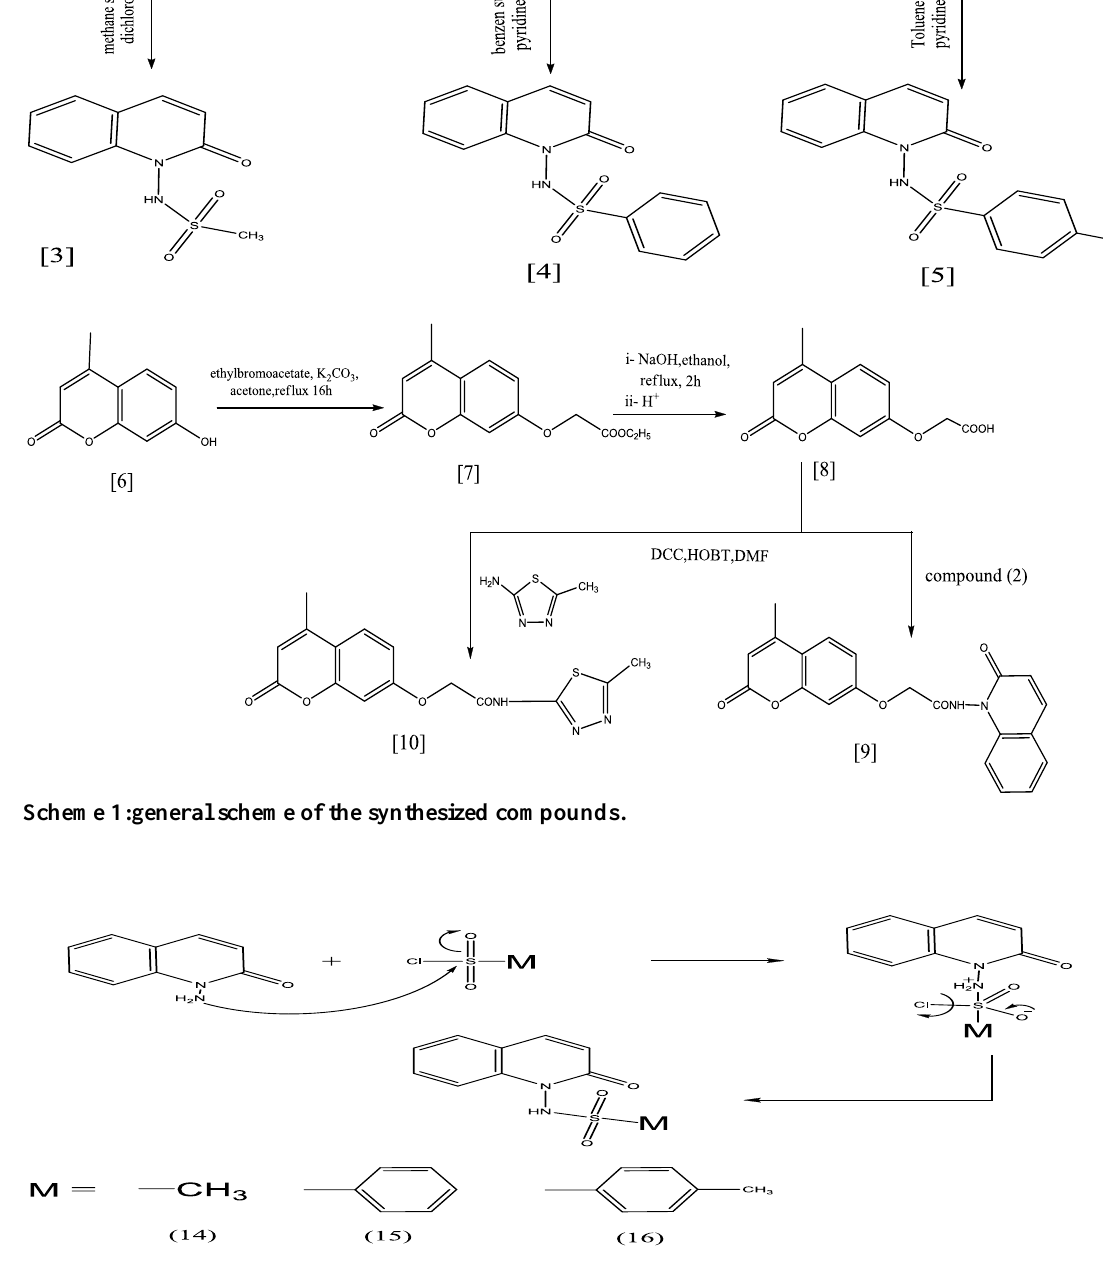
Scheme 2 :Mechanism of sulfonamide